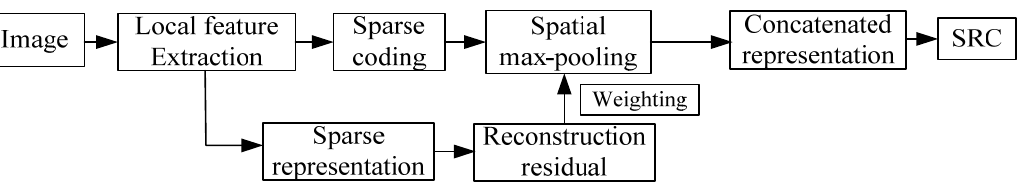
Figure 1. Overview of the SAR image target recognition flowchart.